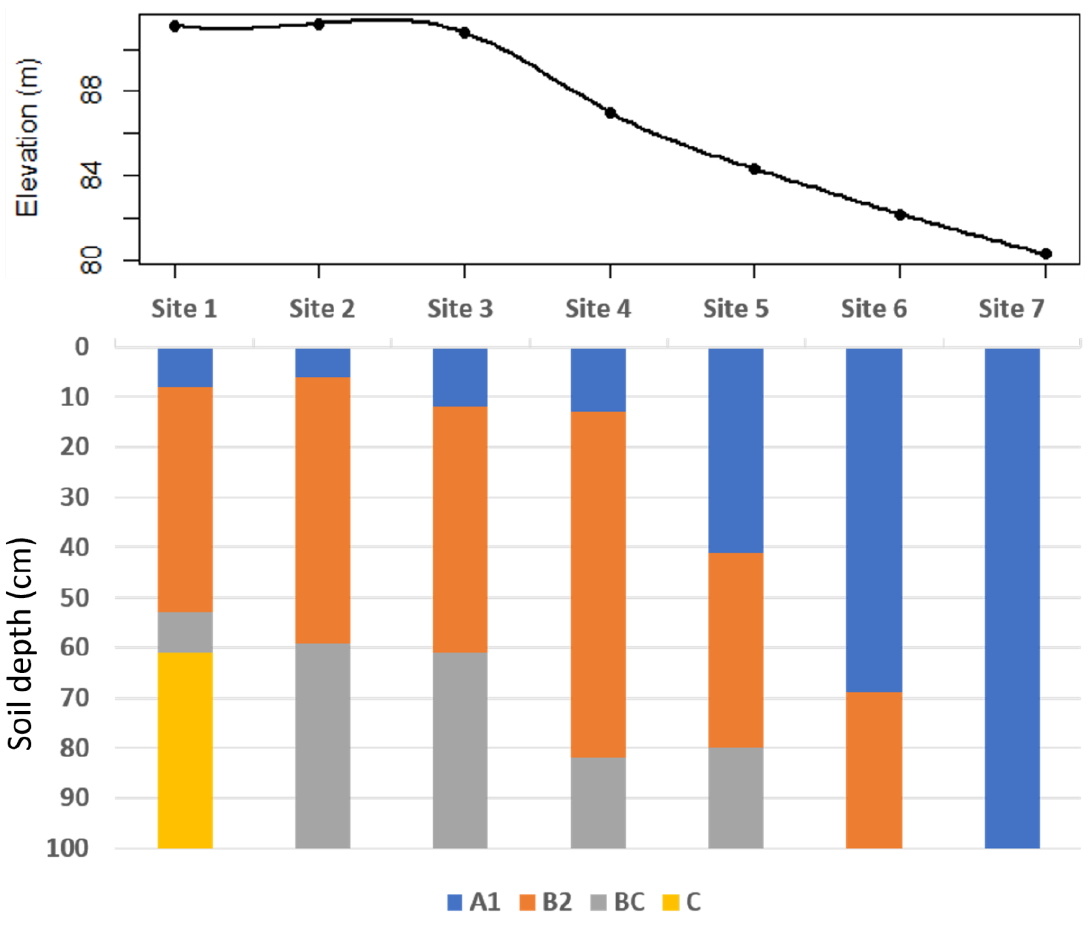
Figure 5. Elevation and observed soil horizons of the seven soil profiles along the transect.